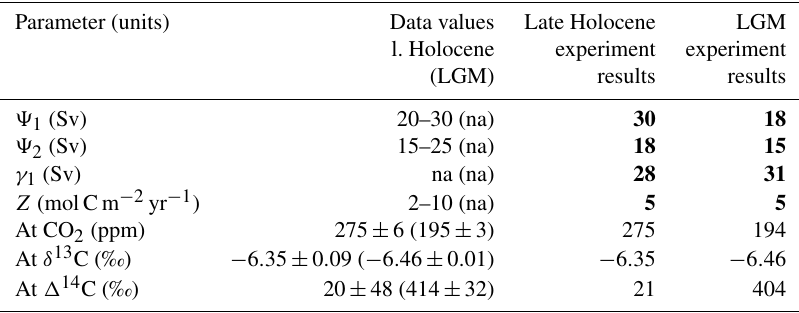
Bold font parameter results indicate those parameters that are free-floating and determined by the model and data in the experiment. The LGM experiment shows a marked decline in the strength of global overturning